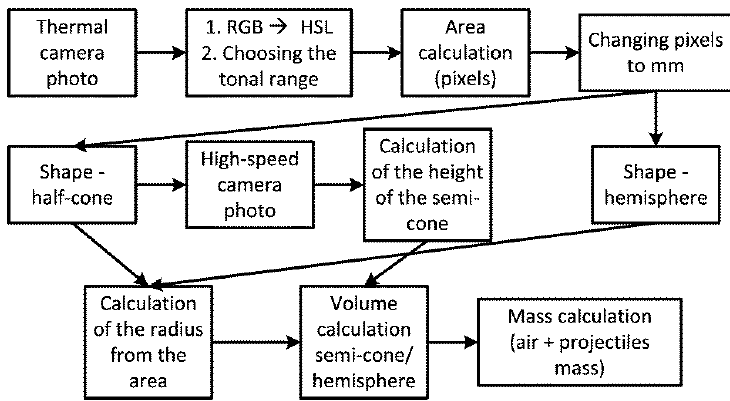
Figure 10. Algorithm for calculating the mass of a cloud of heated air and debris.